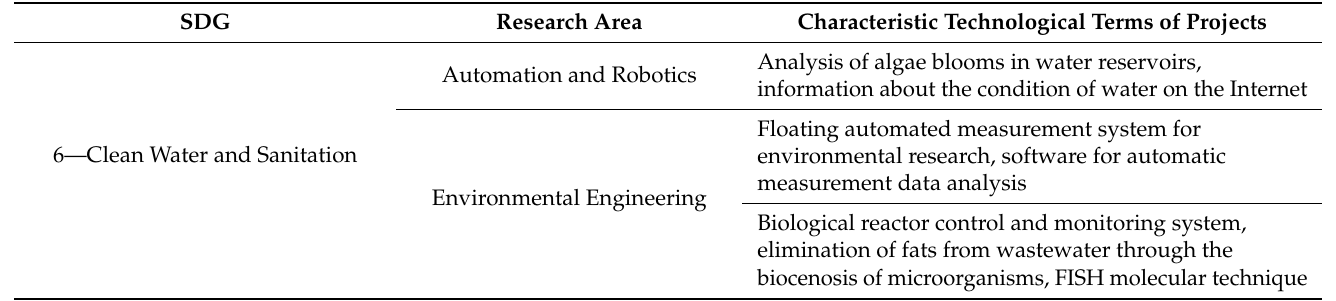
Table 11. Characteristic technological terms of projects for Clean Water and Sanitation. SDG